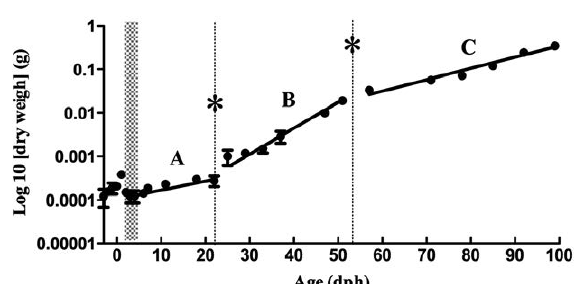
Fig. 3. – Mean weight values of growth in larvae and juveniles of Chelon labrosus as a function of age (1 to 99 dph). Data are plotted on a logarithmic ordinate grid and values are represented as mean ±S.E.M (n=10-30). Linear regression equations for each growth stage (bold lines) were estimated by the least-squares re- gression method using log-transformed data. Vertical dashed lines indicate inflexion periods (i.e. change in regression). Bar represents the moment of the mouth opening (4 days post-hatching, dph). * Represents statistically significant differences between the slope of periods A and B (t=6.532, P<0.05) and periods B and C (t=6.398, P<0.05).